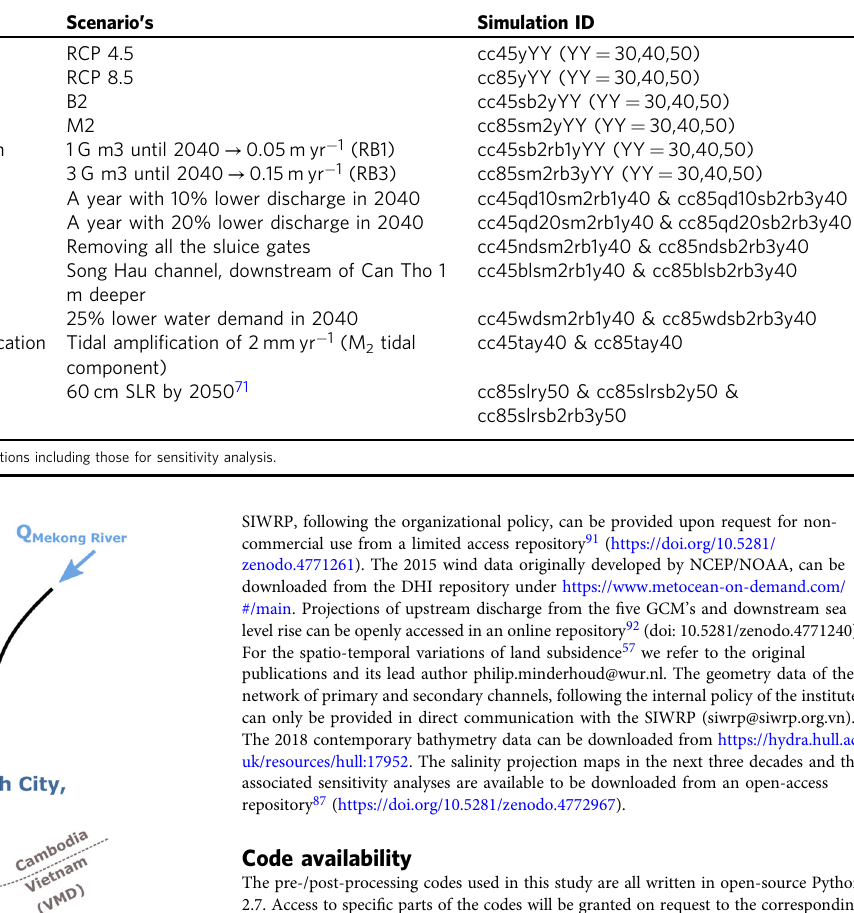
Table 1 The list of projection scenarios and various sensitivity